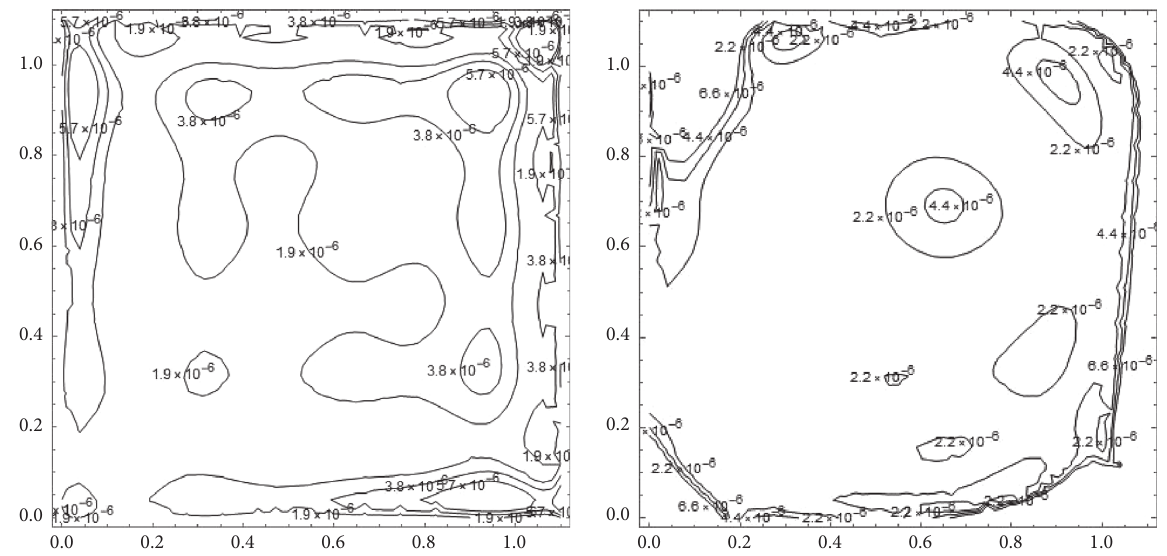
Figure 3: Contour plot errors in both mesh and meshless cases.